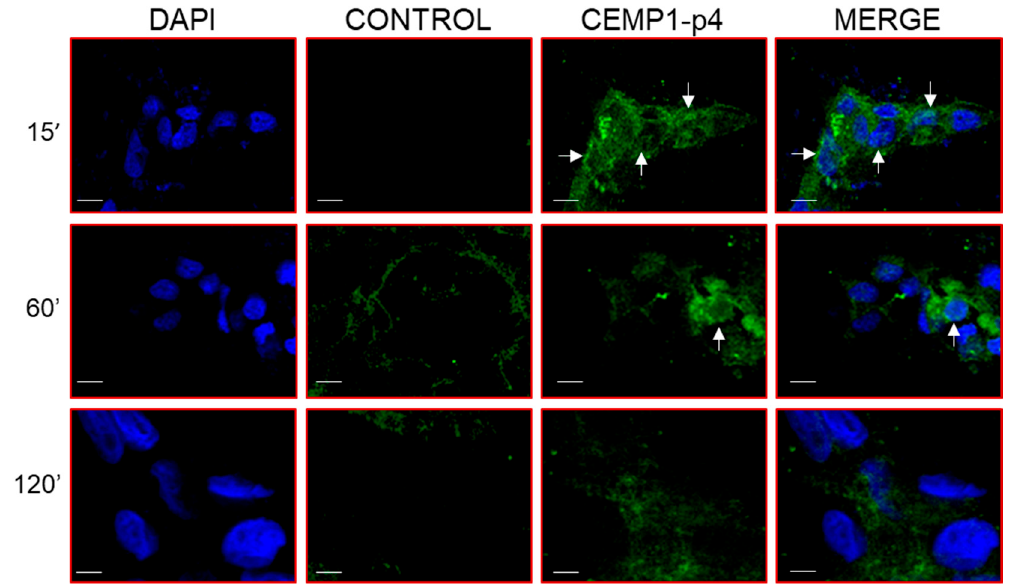
Figure 9. Translocation of β -catenin following HOMSC stimulation with CEMP1-p4 (4 µg/mL) was determined using antihuman β -catenin rabbit polyclonal antibody. Beta-catenin was localized in the cytoplasm from 15 up to 60 minutes. At 120 min after the treatment with CEMP1-p4, β -catenin began to be translocated into the nucleus. Image is representative of data from three independent experiments. Arrows indicate punctuate expression of β -catenin into the cell nucleus. Original magnification, 3400. Bar scale = 10 μ m.